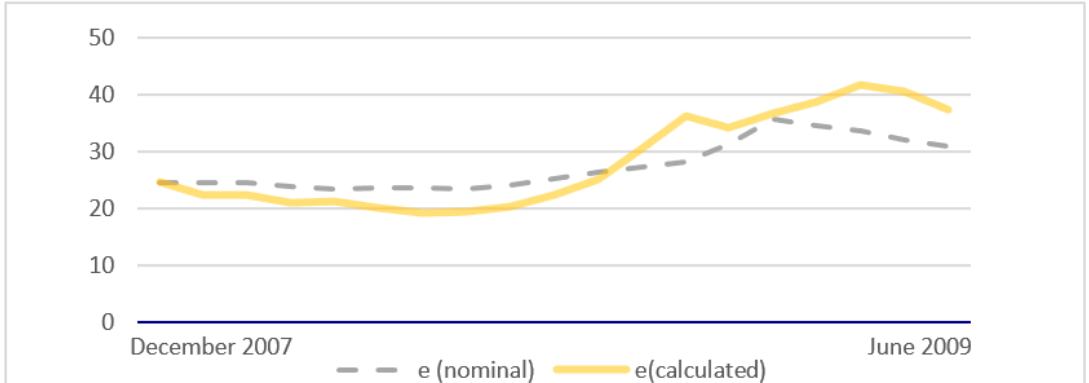
Figure 2. Calculated and nominal USD/RUR exchange rates (December 2007–June 2009, author’s calculations, monthly data).